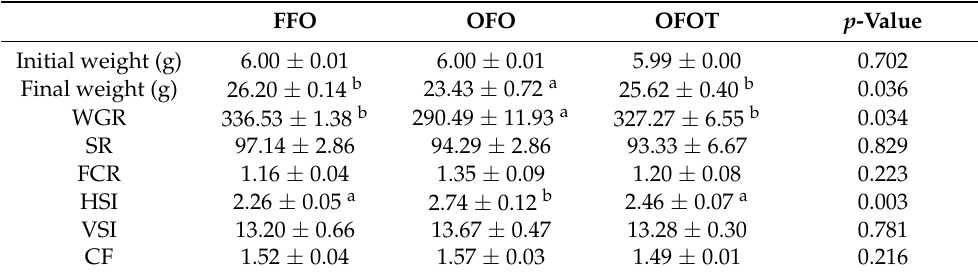
Table 3. Effects of dietary taurine on the growth performance of channel catfish ( Ictalurus punctatus ) fed oxidized-fish-oil